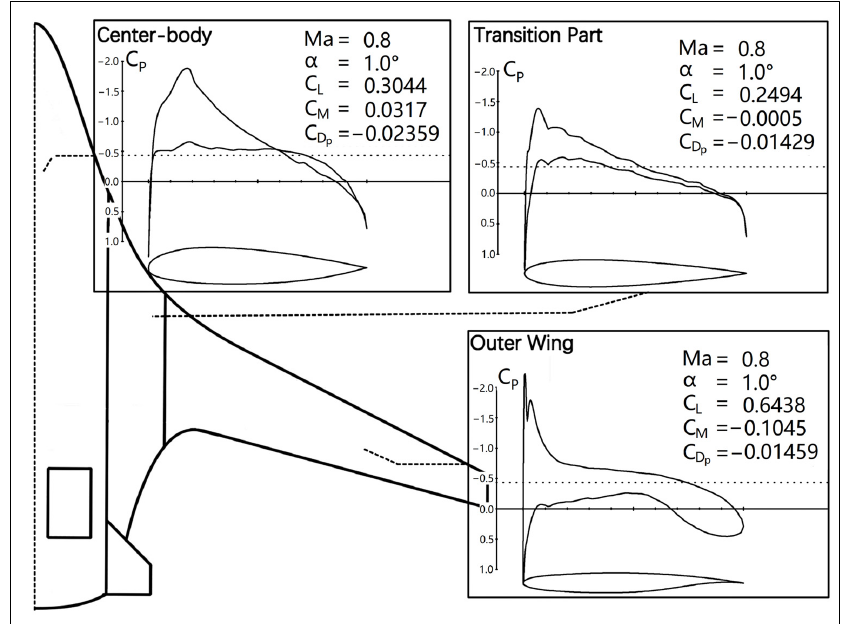
Figure 6. Airfoil sections of the HWB aircraft.